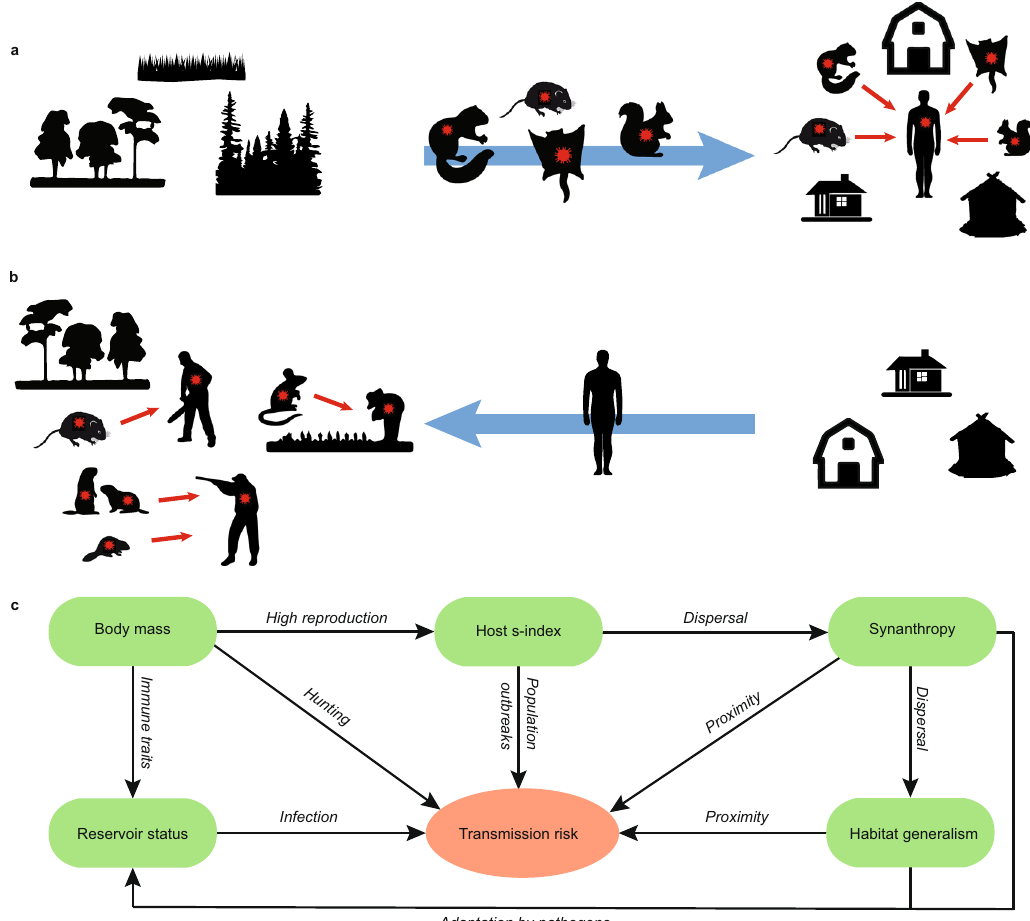
Fig. 1 | Pathways increasing transmission risk from rodent-borne pathogens. a , b Contactbetweenrodentsandhumansincreasestransmissionrisk; a eitherwith rodentsmovingintohumandwellingsandenvironmentsorwith b ,humansmoving intorodenthabitatsorusingrodentsasanaturalresource. c Factors(greenboxes) and associated key traits of mechanisms (arrows) explaining increased transmis- sionriskfromrodent-bornepathogens.Descriptionofmechanisms:Bodymassasa key life history trait can dichotomously increase transmission risk. While rodents with highbodymass are frequently hunted for fur or meat, many rodents with low body mass have less developed immune defence strategies and exhibit